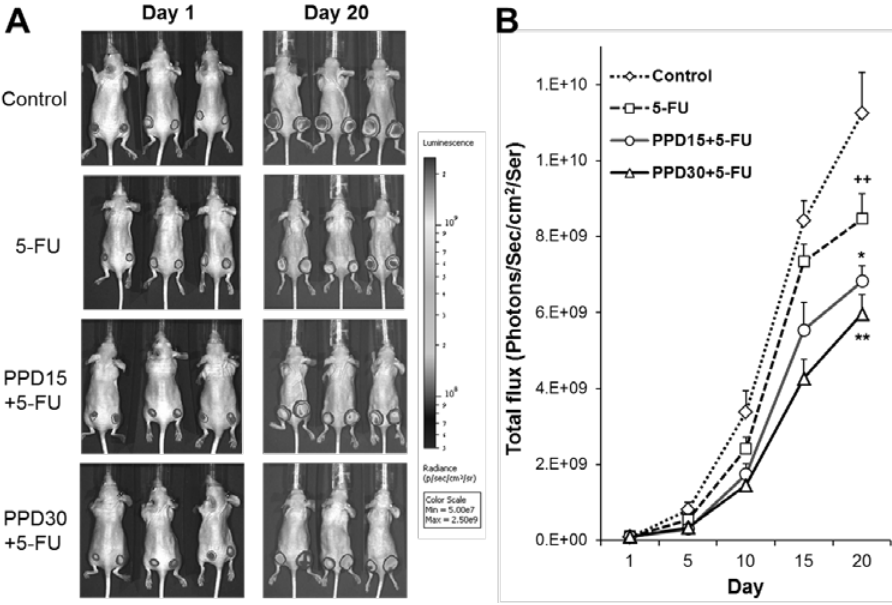
Figure 5. Protopanaxadiol (PPD) enhances the antitumor effects of 5-FU in xenografted athymic mice measured by Xenogen bioluminescence imaging. The tumor growth is monitored from Day 1 (7 days after human colon cancer cell HCT-116 inoculation) to Day 20. ( A ) Representative Xenogen imaging results from animals in different treatment groups; ( B ) quantitative analysis of Xenogen bioluminescence imaging data. Average tumor sizes at the indicated time points are expressed with imaging signal intensities (photons/second/cm 2 /ser). n = 8/group. 5-FU, 5-FU 30 mg/kg; PPD15 + 5-FU, PPD 15 mg/kg plus 5-FU 30 mg/kg; PPD30 + 5-FU, PPD 30 mg/kg plus 5-FU 30 mg/kg. ++ p < 0.01 compared to the model group; * p < 0.05; ** p < 0.01 compared to the 5-FU